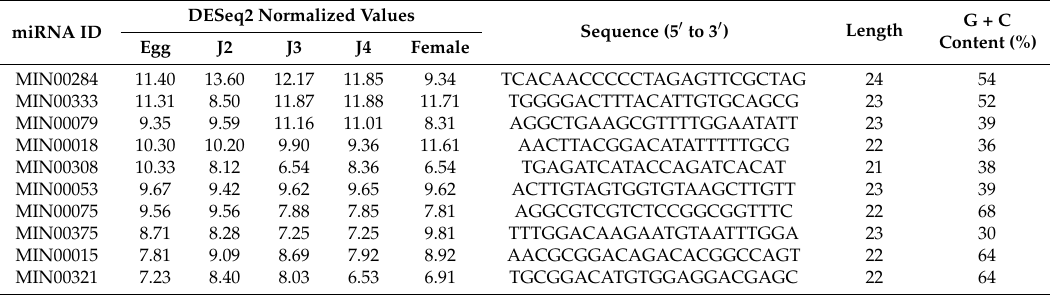
Table shows highly expressed novel miRNA families across all the stages of the M. incognita life cycle. Read counts from sequencing data were compared and normalized to obtain the DESeq2 values.